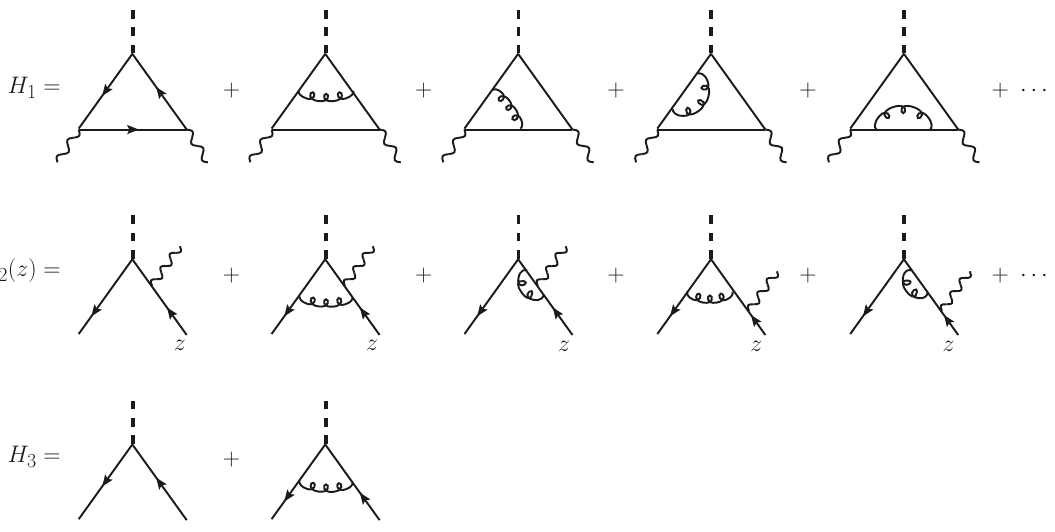
Figure 6 . Representative Feynman diagrams contributing to the hard matching coe(cid:14)cients H i up to O ( (cid:11) s ). In the case of H 1 we do not show the mirror graphs of the third and fourth diagram, in which the gluon is attached on the other side. In the case of H 2 we omit the corresponding diagrams with the photon attached to the other quark